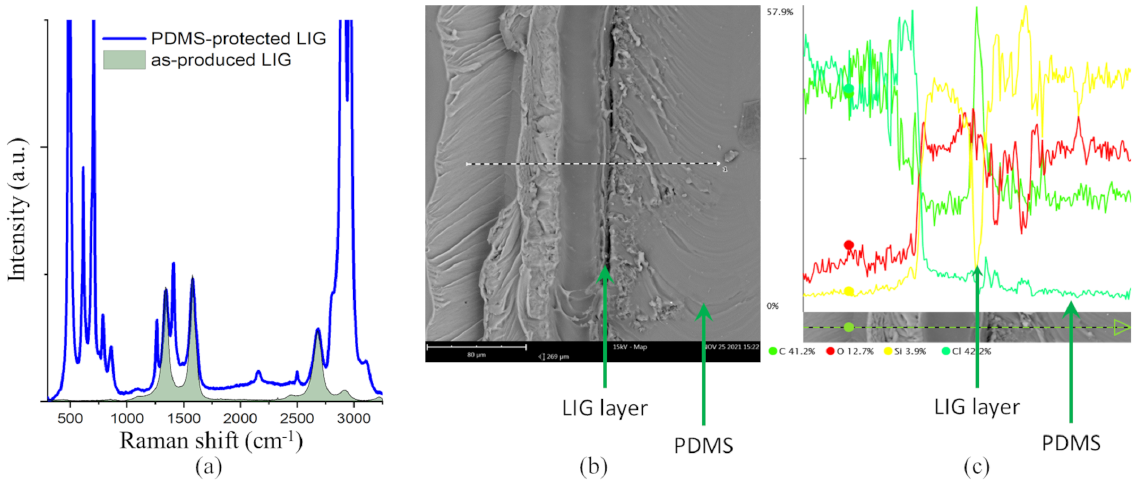
Figure 3. Raman spectra, SEM, and EDX characterization of PDMS-covered LIG layer. ( a ) Raman spectra of the as-produced LIG sample before (shaded) and after covering with PDMS protective layer. ( b ) SEM image of a cross-section of the PDMS-covered LIG layer on PI. ( c ) EDS line scan across the dashed white line depicted in panel ( b ). Different colored lines indicate different elements, as stated in the legend below the